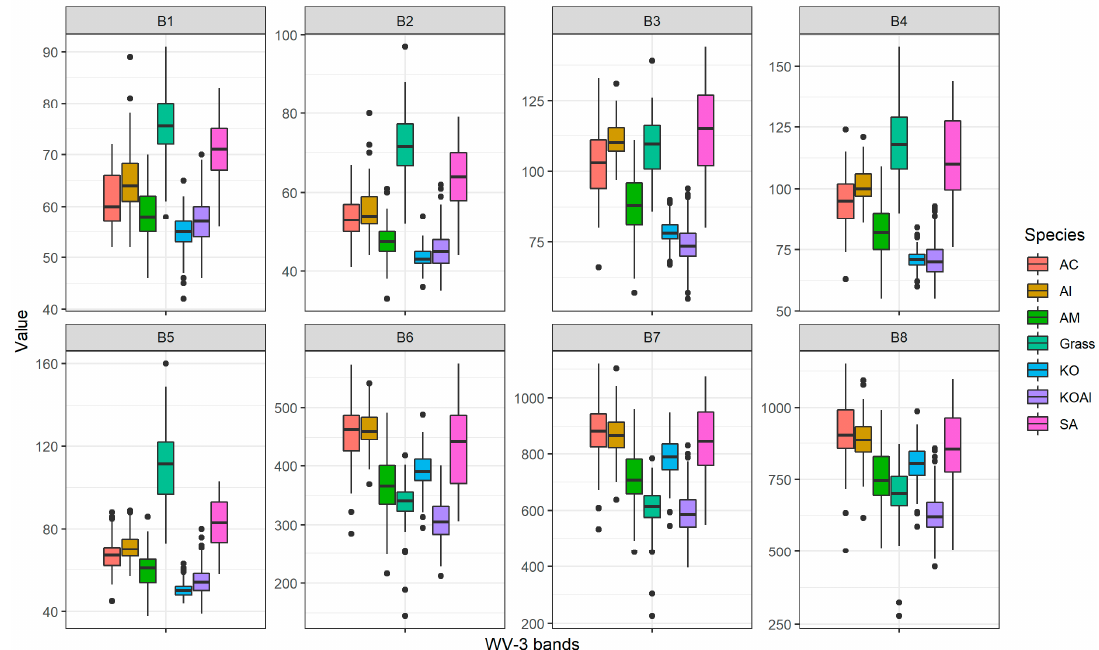
Figure 3. Difference among species in WV-3 MS bands value (B1: coastal blue band, B2: blue band, B3: green band, B4: yellow band, B5: red band, B6: red edge band, B7: NIR1 band, and B8: NIR2 band).